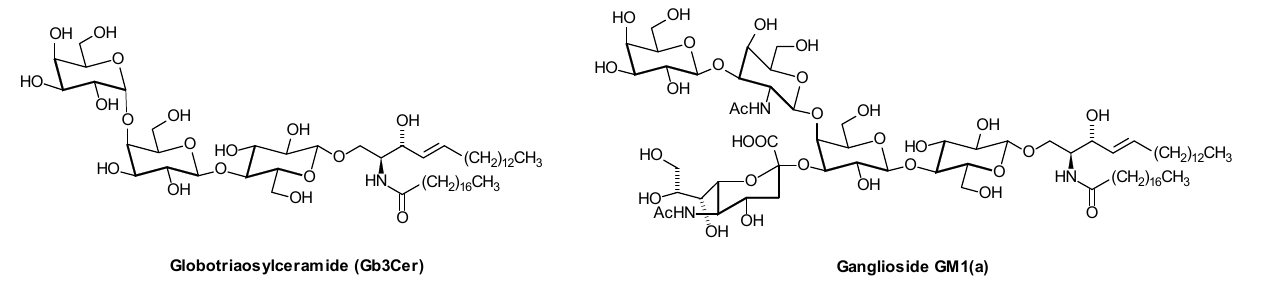
Figure 6. Structures of the toxin receptors Gb3Cer and ganglioside GM1. Only one of the various lipoforms is shown. Gb3Cer is the major storage substance in Fabry disease (  -galactosidase A deficiency), and GM1 in GM1-gangliosidosis (GM1-  -galactosidase